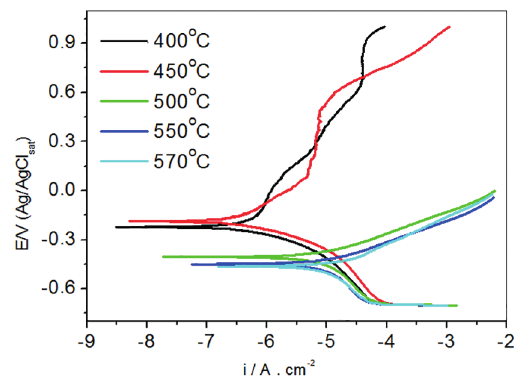
Figure 14: F-53 steel potentiodynamic polarisation curve at different nitriding temperatures for a 0.6 M NaCl solution and a 0.5 mV. s -1